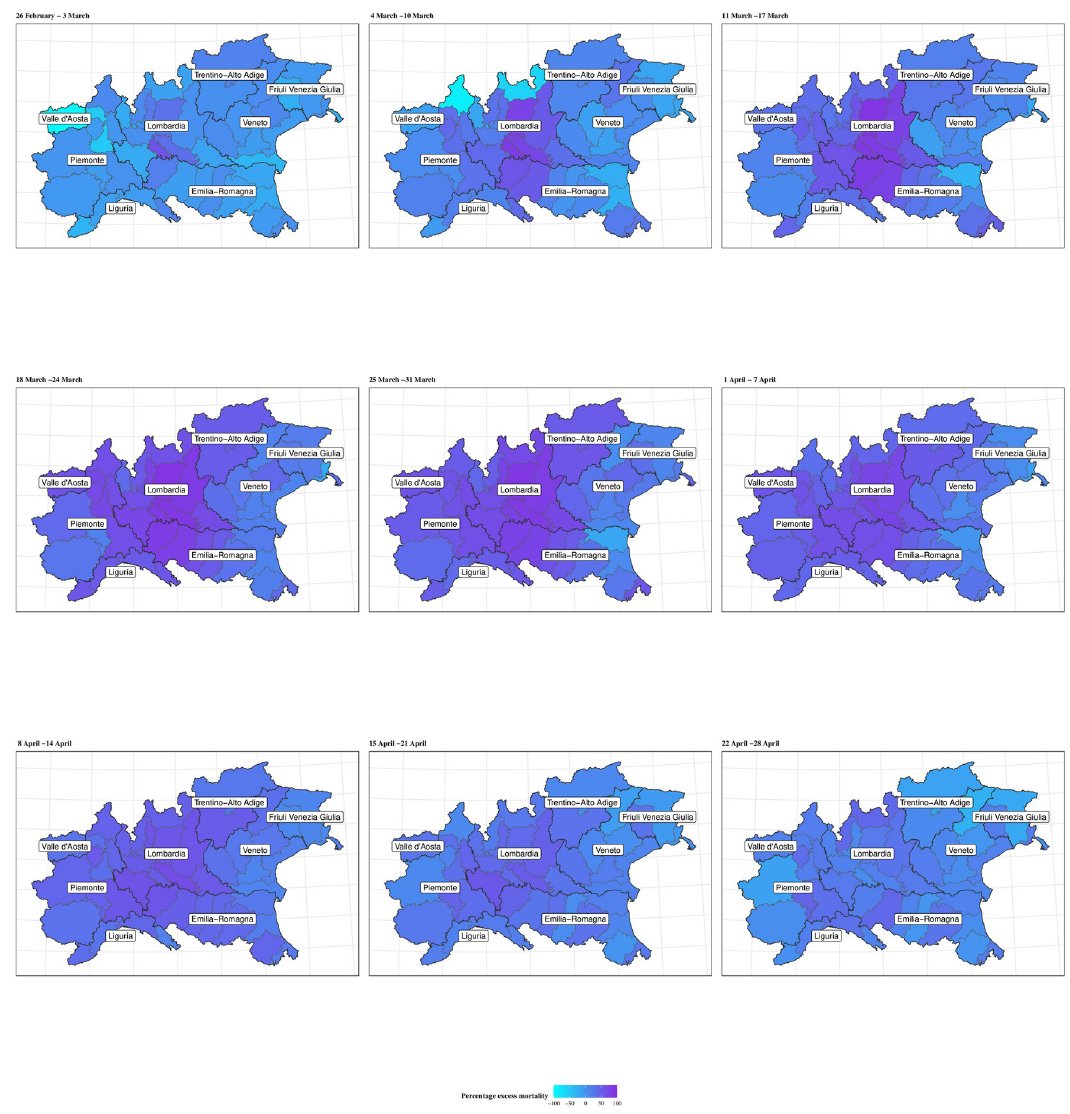
Fig 3. Percent excess mortality. Map of the percent excess mortality for the provinces in the areas of North-West, Lombardia and North-East of Italy, weekly posterior predictive mean in 2020 for males. Period: 25 February–28